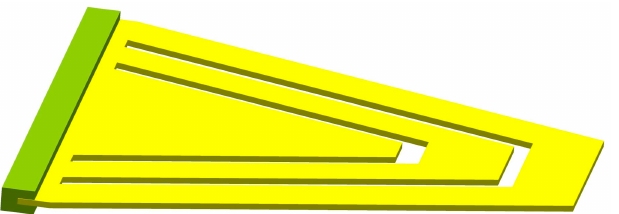
Figure 16. Division of a trapezoidal cantilever beam into some V-shaped beams [100]. Shi et al. [102] also examined broadband piezoelectric vibration energy harvesting.